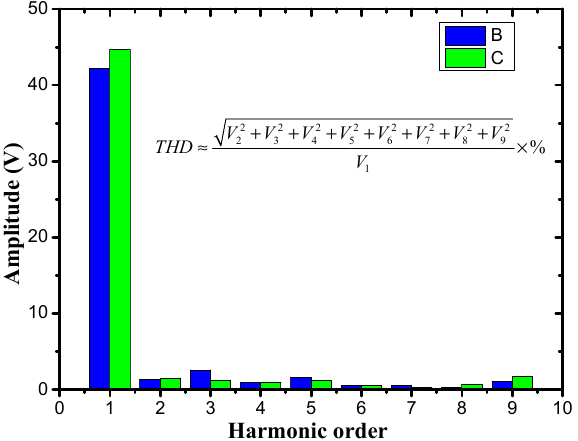
Figure 24. Spectra of phase back-EMF of the initial model and the optimized model.